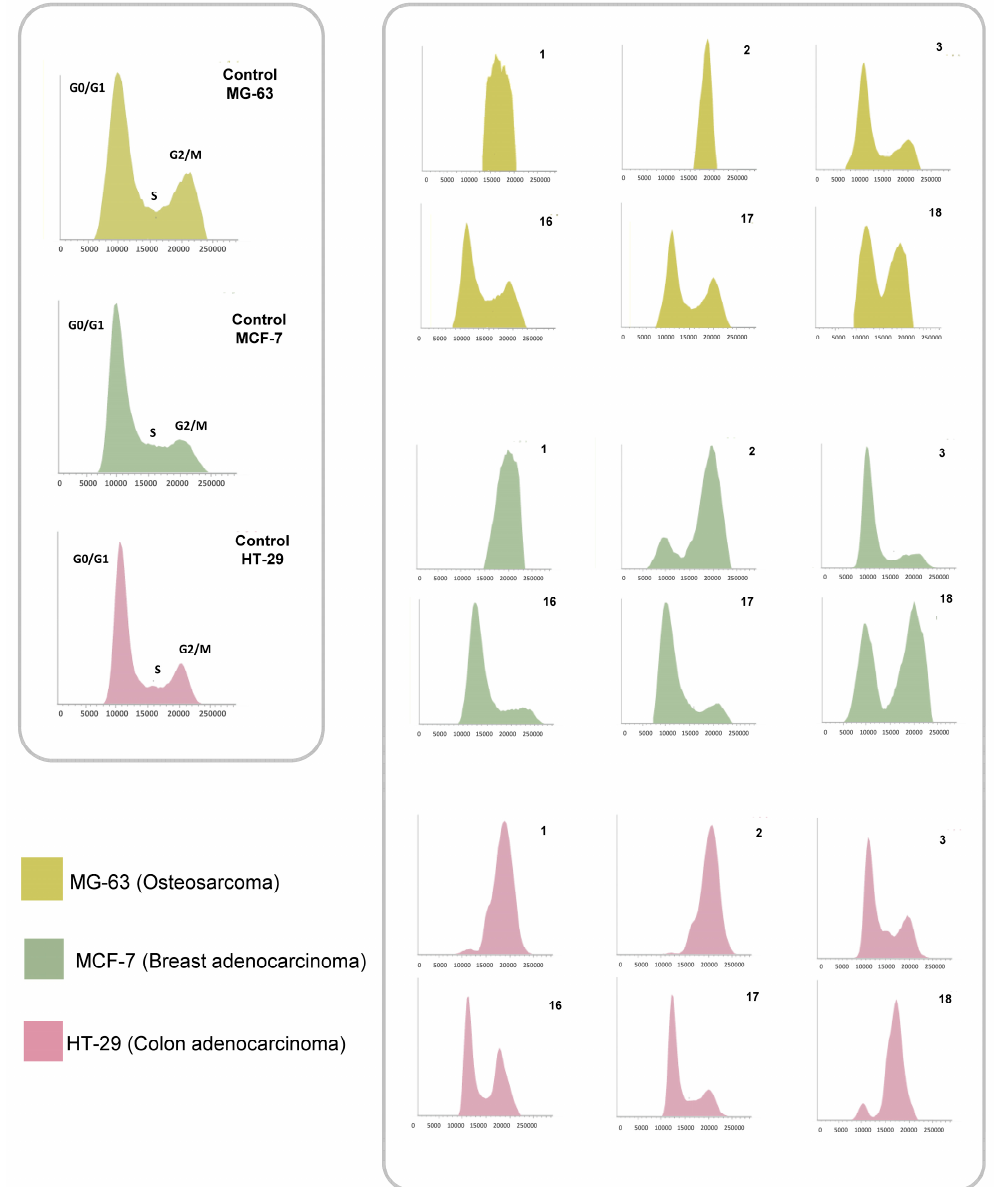
Figure 4. Effect of the precursors 1 – 3 and the hybrids 16 – 18 on DNA-ploidy determined by flow cytometric analysis to determine cell cycle phase. The cells were incubated with 1 µM of the indicated compound and control for each line with the vehicle (DMSO, <0.001%) for 24 h. As expected, cyclolignans 1 and 2 blocked the cell cycle almost completely in the Starting with the dose–response plots of the compounds at different incubation three lines studied, whereas MHQ 3 had no effect on the cell cycle. For the hybrids, the results varied considering the chemical characteristics of the spacers. In general, L-MHQs with aliphatic spacers ( 16 and 17 ) did not show a cell cycle blockade at this incubation